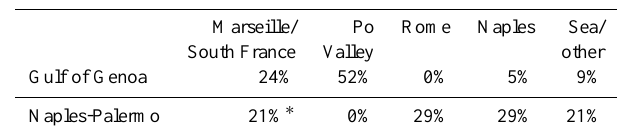
Table 4. Likely main source areas of ozone precursors for high ozone episodes observed in the Gulf of Genoa (21 episodes) and along the track Naples-Palermo (14 episodes) during April–August 2006 and 2007, according to the analysis of back trajectories (see